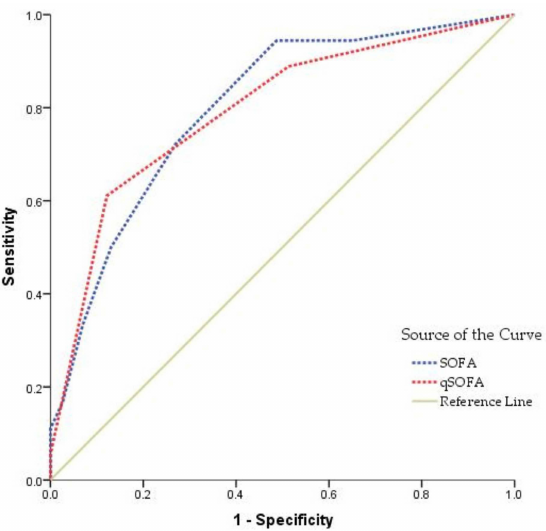
Figure 1. Receiver operating characteristic curve of SOFA and qSOFA in predicting mortality. Table 2. The AUC–ROC of SOFA and qSOFA in predicting in-hospital mortality. Risk Score AUC Std. Error p -Value SOFA 0.800 0.054 qSOFA